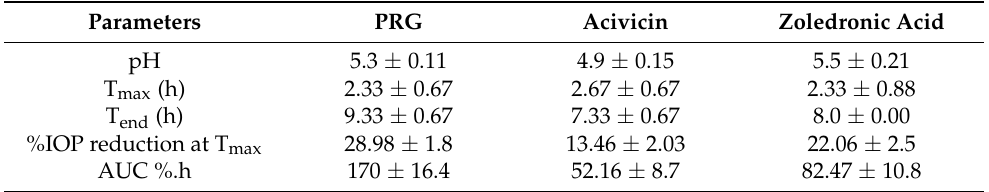
eters after topical application of a single dose of different viscous eye drops to Dutch belted